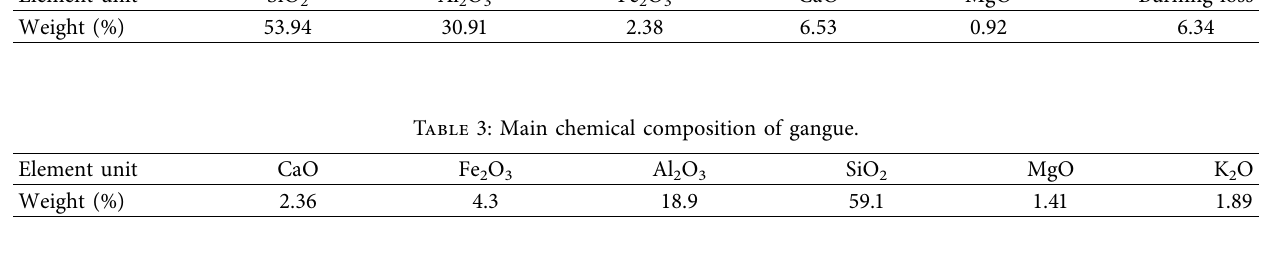
Table 4: Grain size grading of gangue.